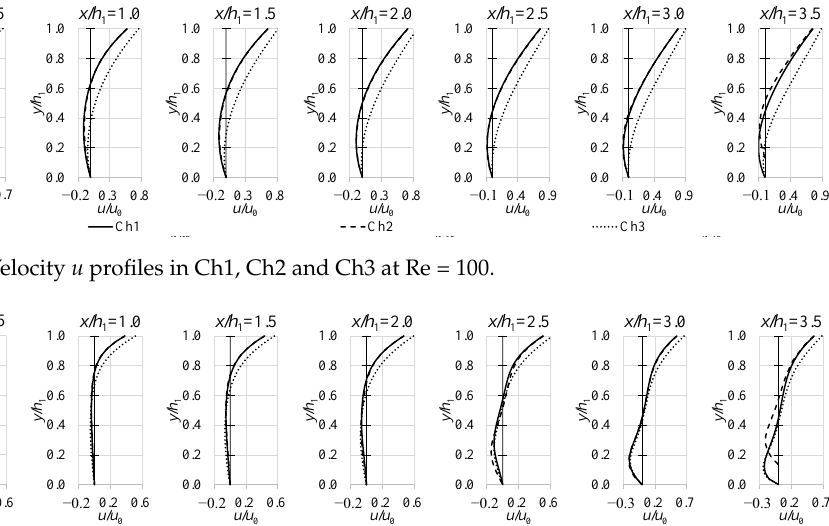
C dependency on Re ( b ).